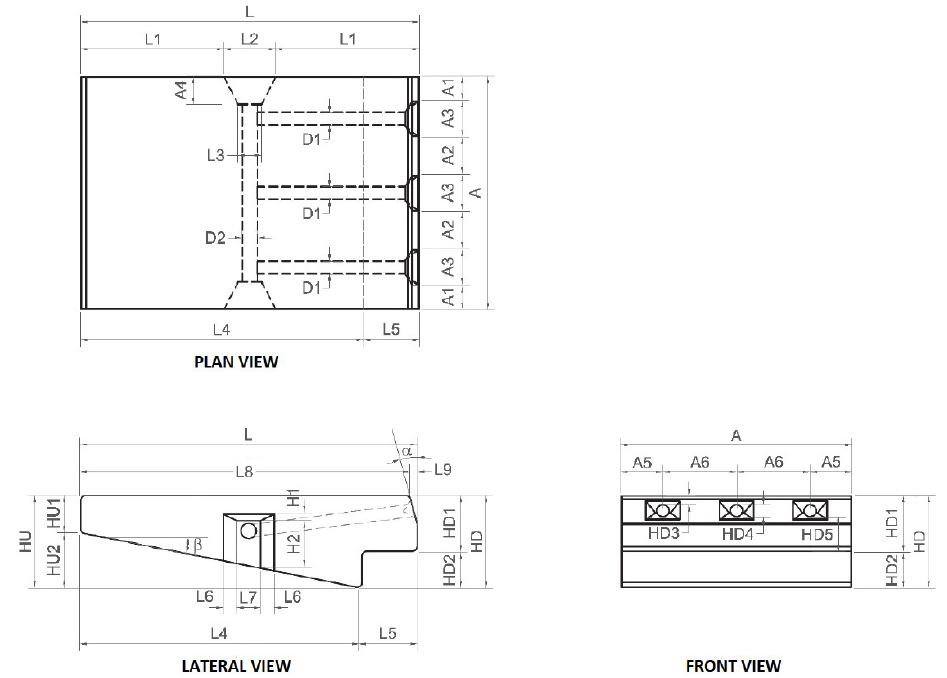
Figure 7. Geometrical parameters of the ACUÑA ® blocks. The WSBs were placed in horizontal rows, starting from the bottom row (row #1) and Table 1. Dimensions and weights of the three sizes of the tested blocks. working upward. WSB placement used a staggered configuration of longitudinal